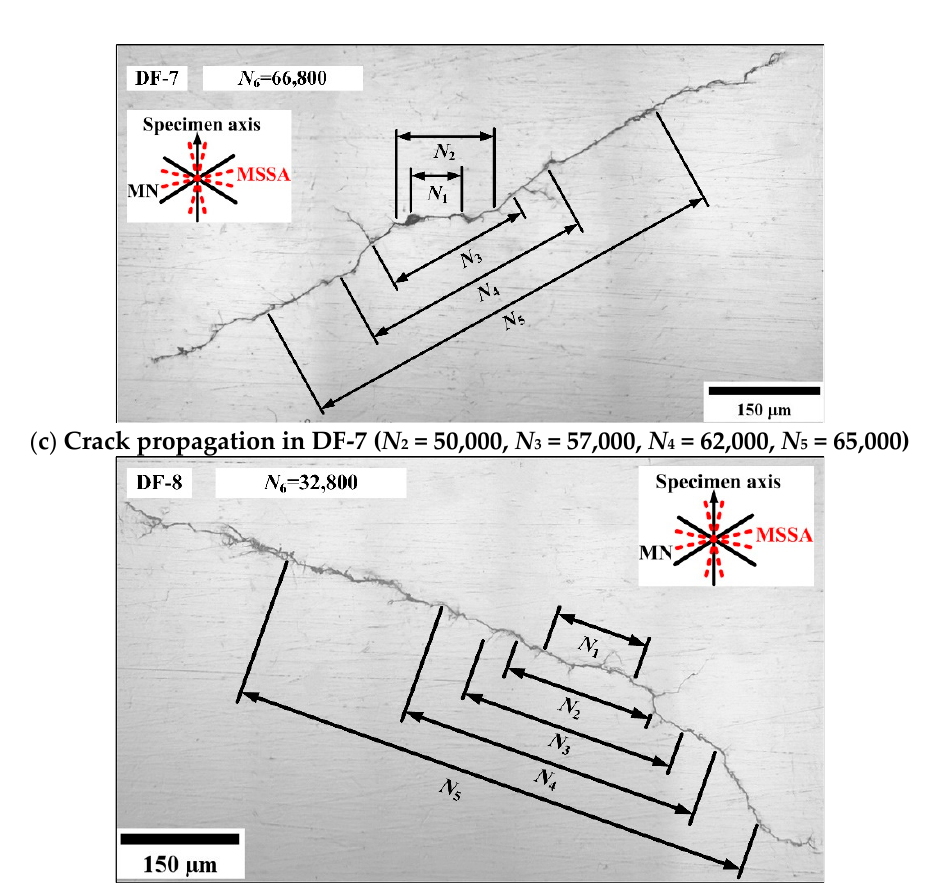
Figure 11. Crack morphologies in specimens DF-7 and DF-8.